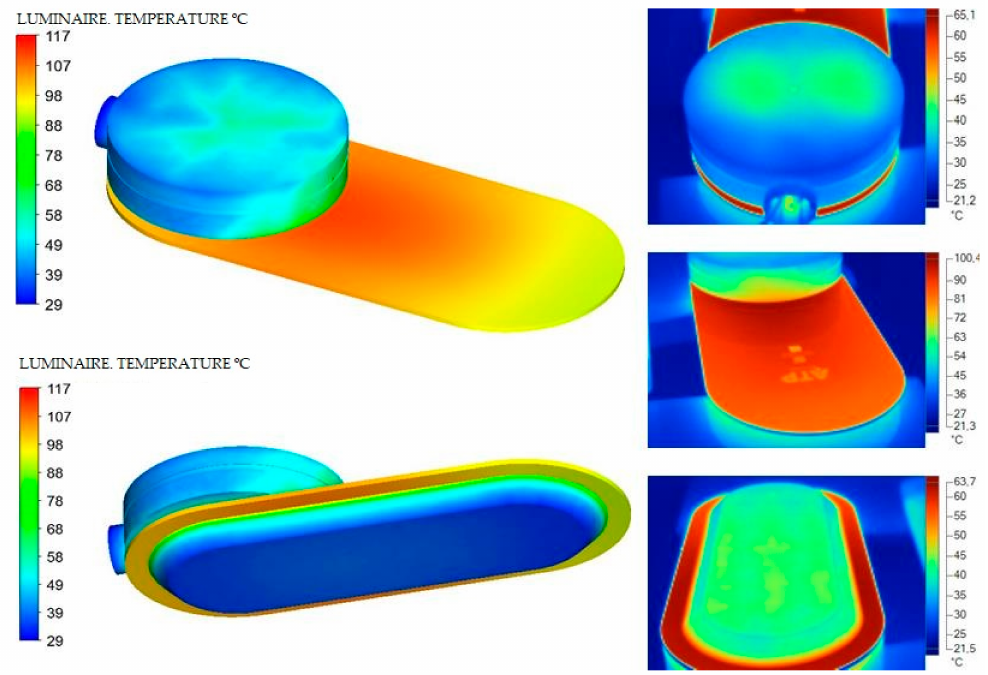
Figure 27. Comparative theoretical data ( left ) and experimental data ( right ). Source: our own elaboration from the software HyperView and SmartView